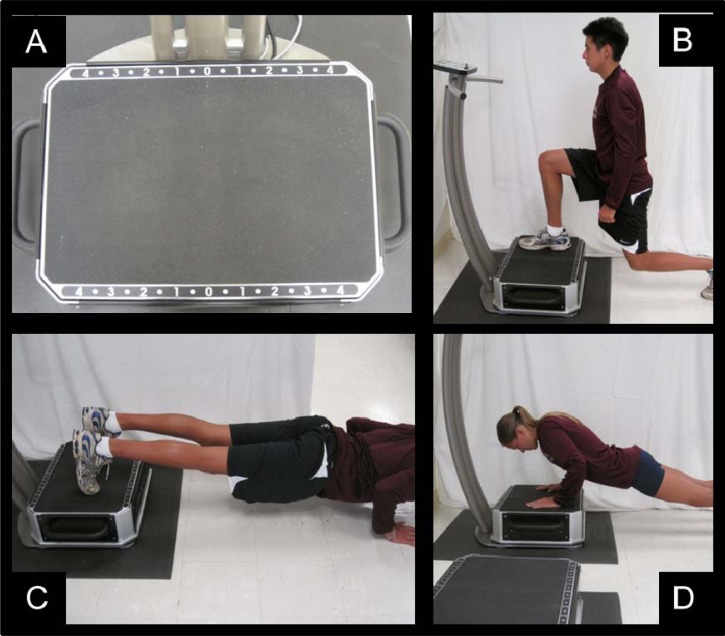
Whole Body Vibration Platform and ExercisesA. Whole body vibration platform, participants were instructed to place their feet at position 2 indicated at the top and bottom of the platformB. Lunging exercise on the whole body vibration platformC. Push-up hold completed with feet placed on whole body vibration platformD. Push-up hold completed with hands placed on whole body vibration platform